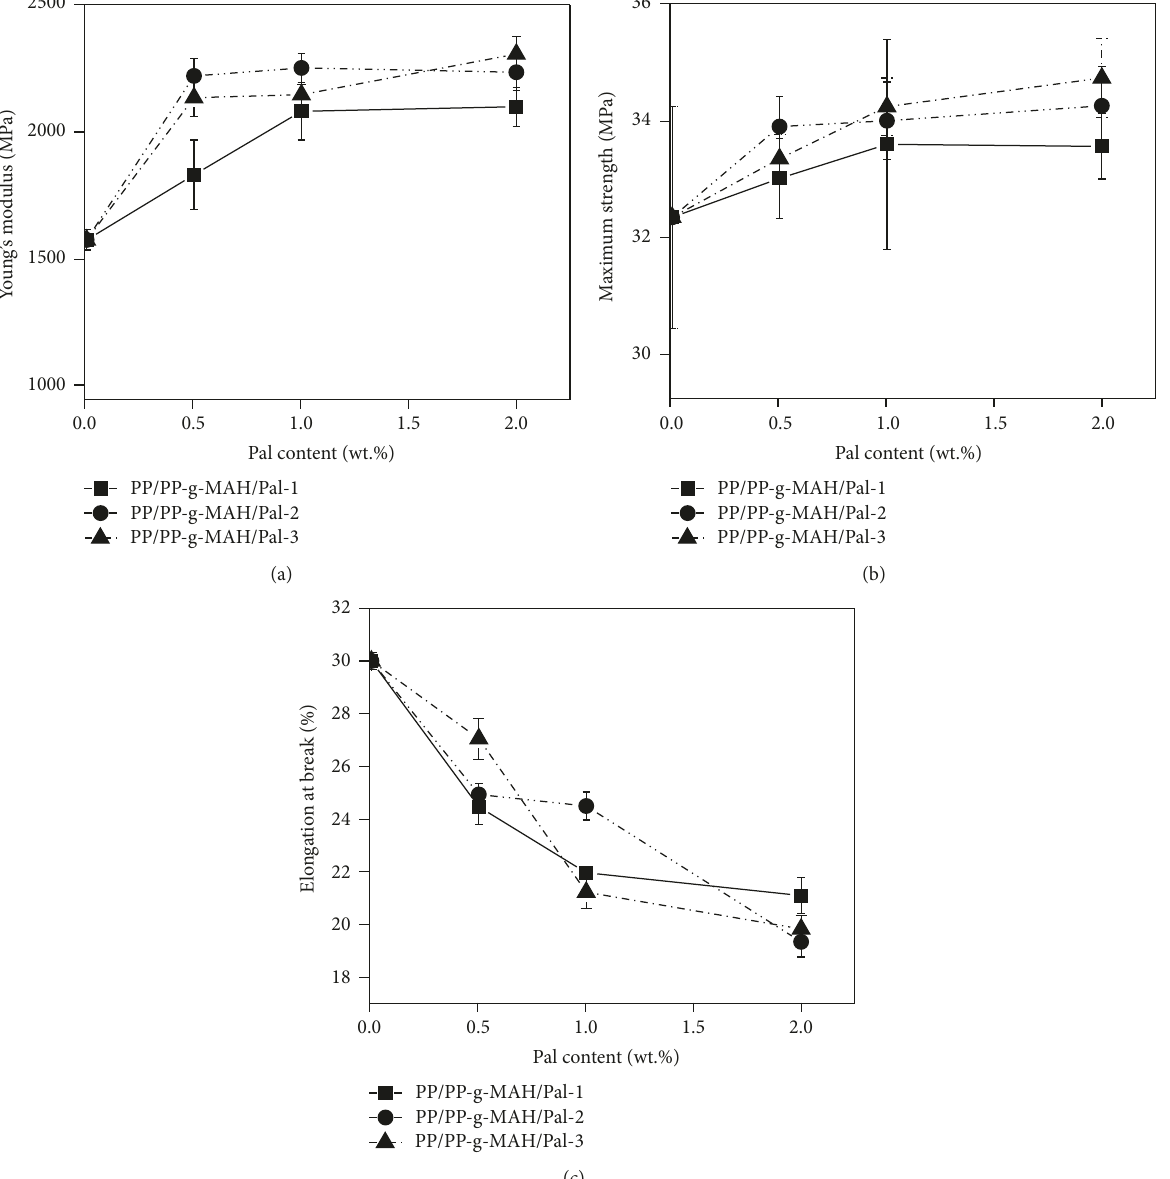
Figure 6: Mechanical properties of PP/PP-g-MAH/Pal nanocomposites: (a) Young’s modulus, (b) maximum strength, and (c) elongation at the